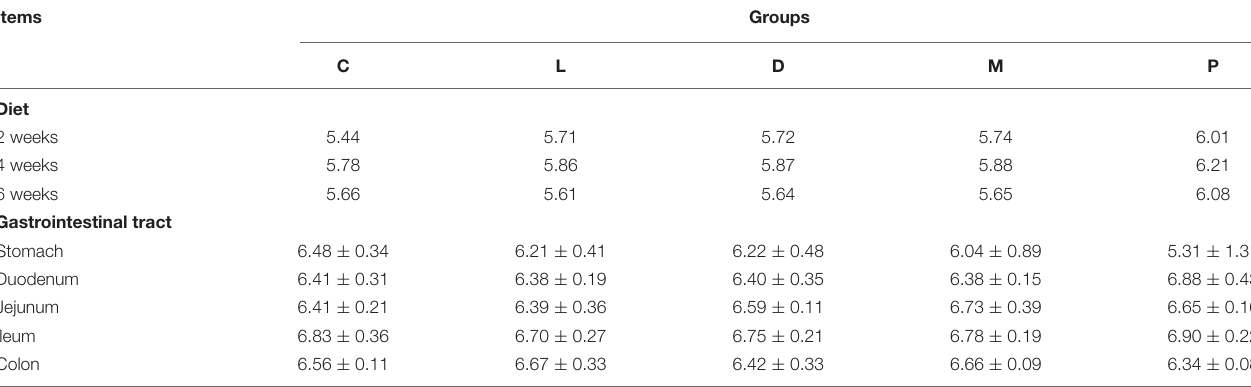
TABLE 5 | Effects of different calcium sources on diet and gastrointestinal pH of weaned piglets. Items